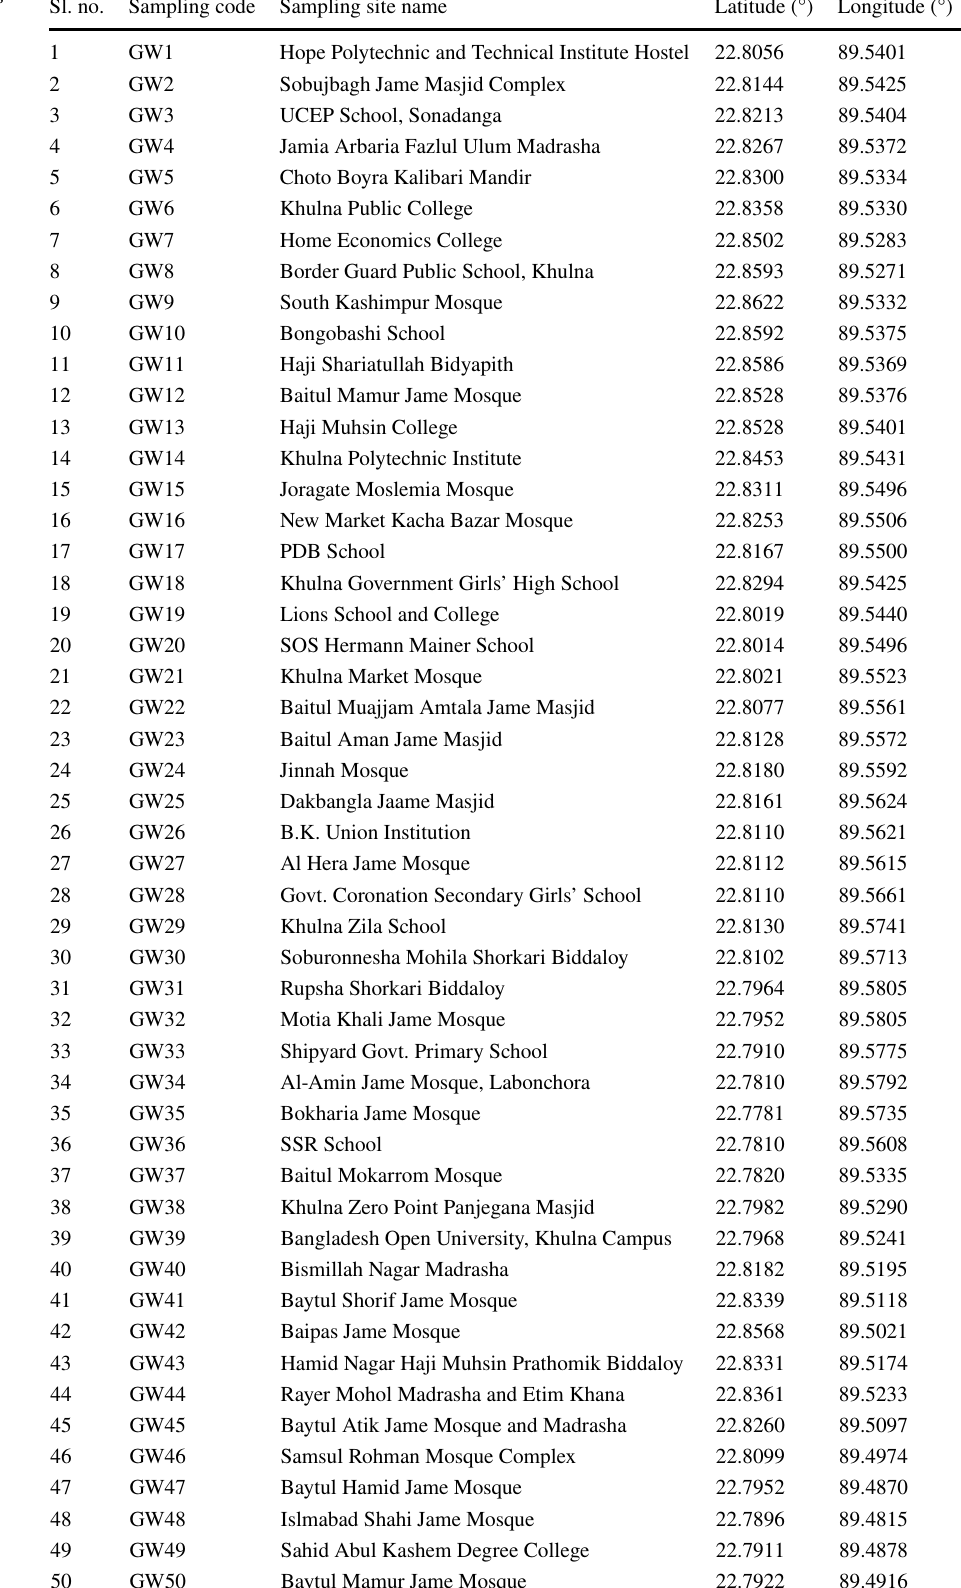
Table 1 Name of sampling sites and location’s